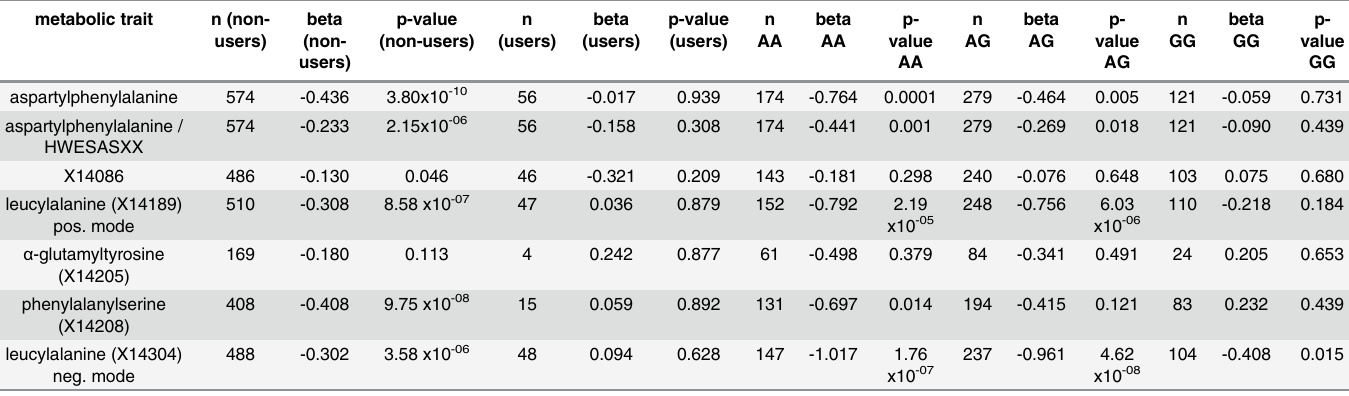
Table 2. Replication results from the TwinsUK study for rs4329.